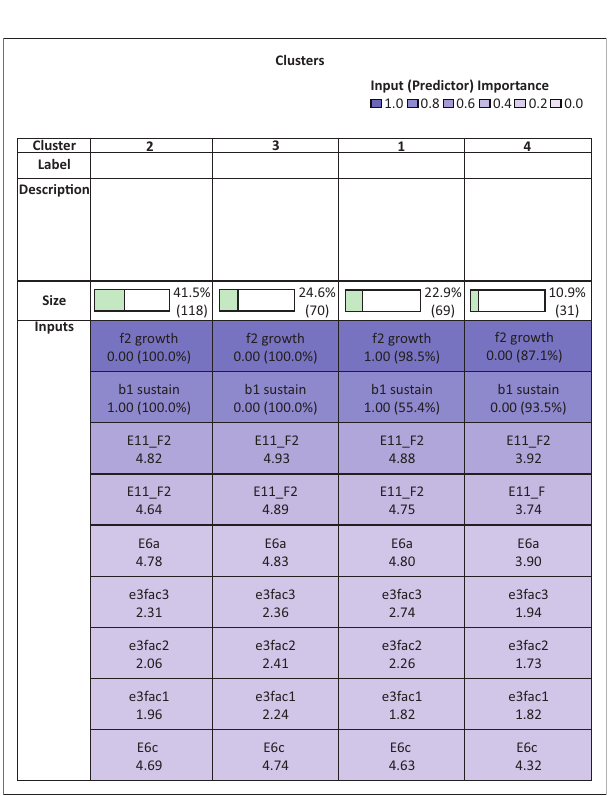
FIGURE 1: Cluster